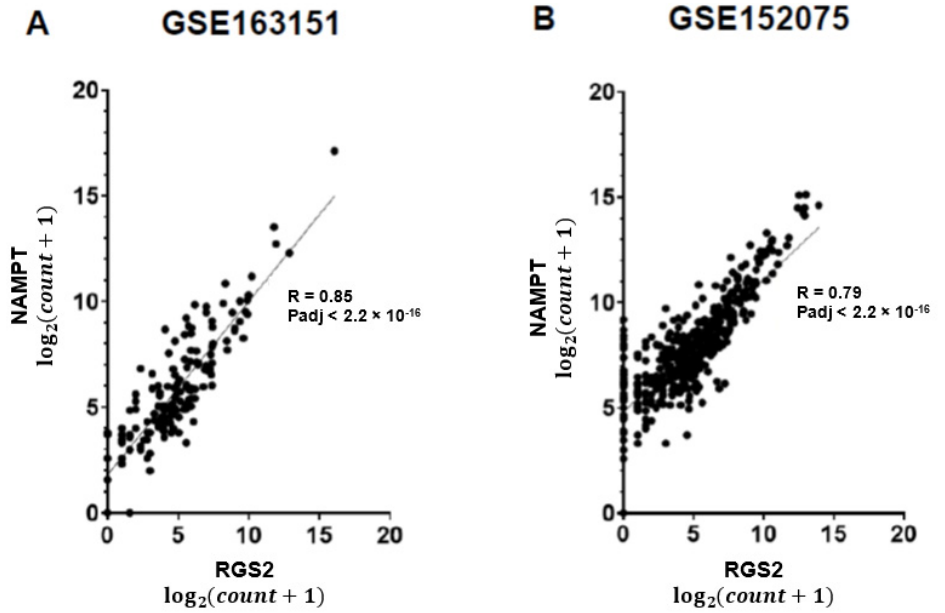
Figure 4. Positive correlation between expression levels of RGS2 and NAMPT from RNA-sequencing of nasopharyngeal swabs. Spearman correlations are shown for ( A ) dataset GSE163151; ( B ) dataset GSE152075.